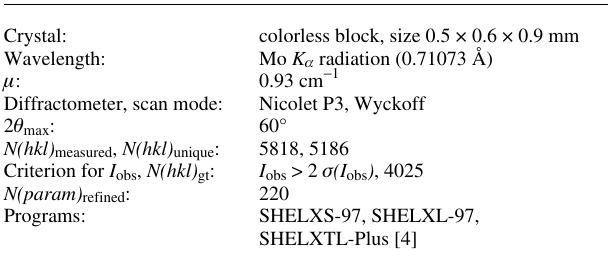
Table 1. Data collection and